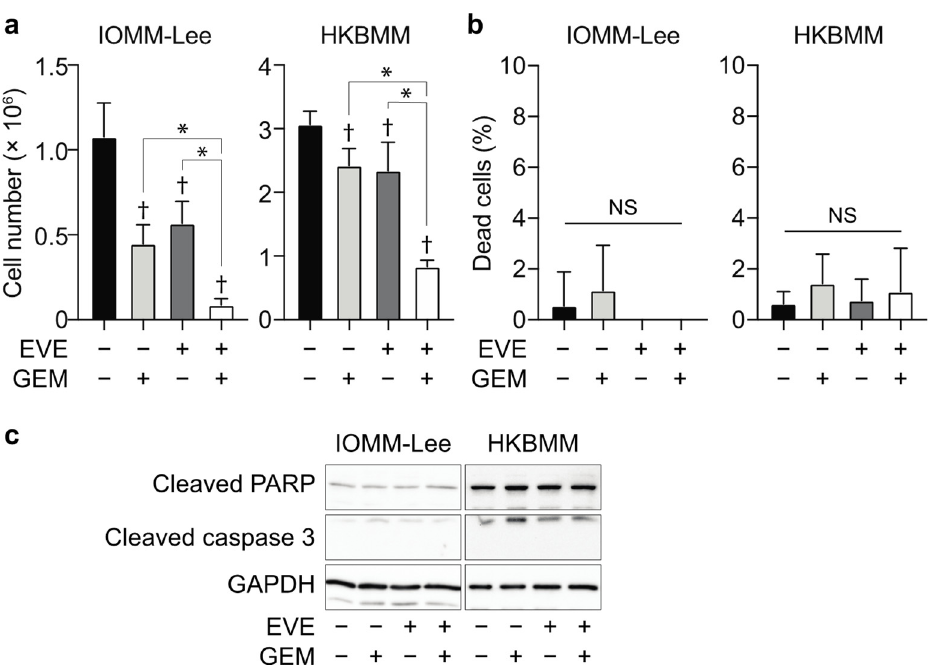
Figure 2. Effects of the combination of everolimus and gemcitabine on malignant meningioma cells. ( a ) IOMM-Lee and HKBMM cells plated on 6-well plates in 6 replicates (5 × 10 4 cells per well for IOMM-Lee and 2 × 10 5 cells per well for HKBMM) were incubated without or with everolimus (EVE, 5 nM) for 4 days in the absence or presence of gemcitabine (GEM, 3 nM for IOMM-Lee and 2 nM for HKBMM) and subjected to a cell viability assay to assess the viable cell number ( a ) and percentage of dead cells ( b ), or to an immunoblot analysis to examine the expression of the indicated proteins ( c ). Similar results were obtained from 2 independent biological replicates. Values are shown as mean + SD. p -values were calculated by a one-way ANOVA with Tukey’s post hoc test ( a ) or by the Kruskal–Wallis test ( b ). * p < 0.05. † p < 0.05, vs. the Control (EVE − and GEM − ). NS: p ≥ 0.05.